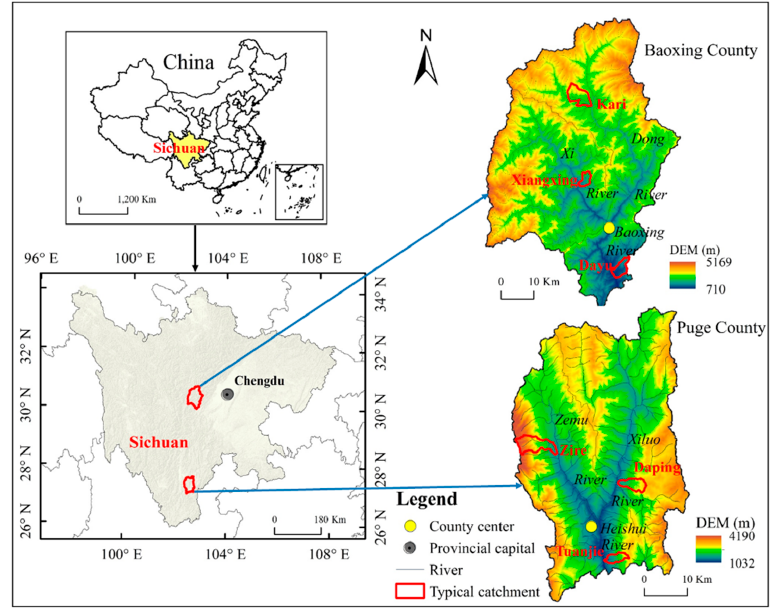
Figure 1. Location of the study areas.